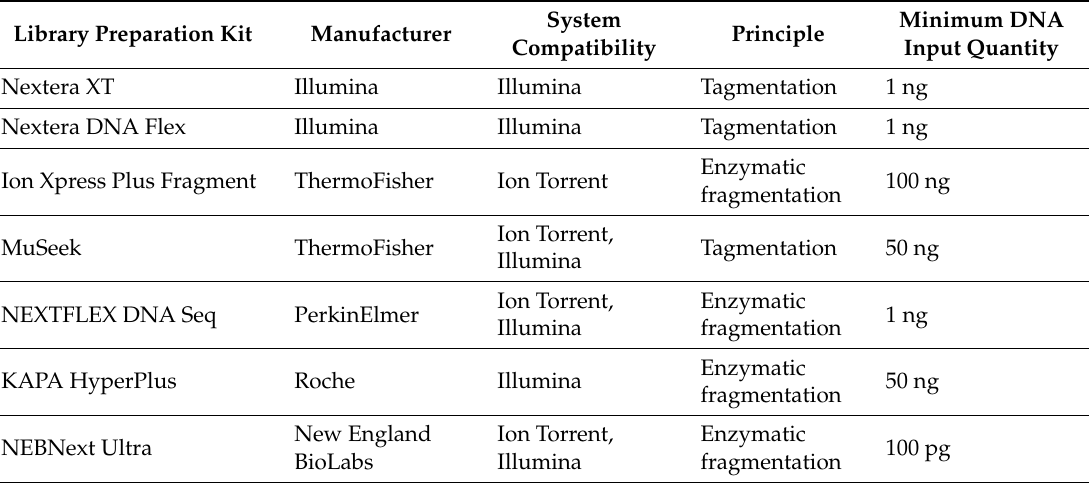
Table 2. Examples of commercially available kits for NGS library